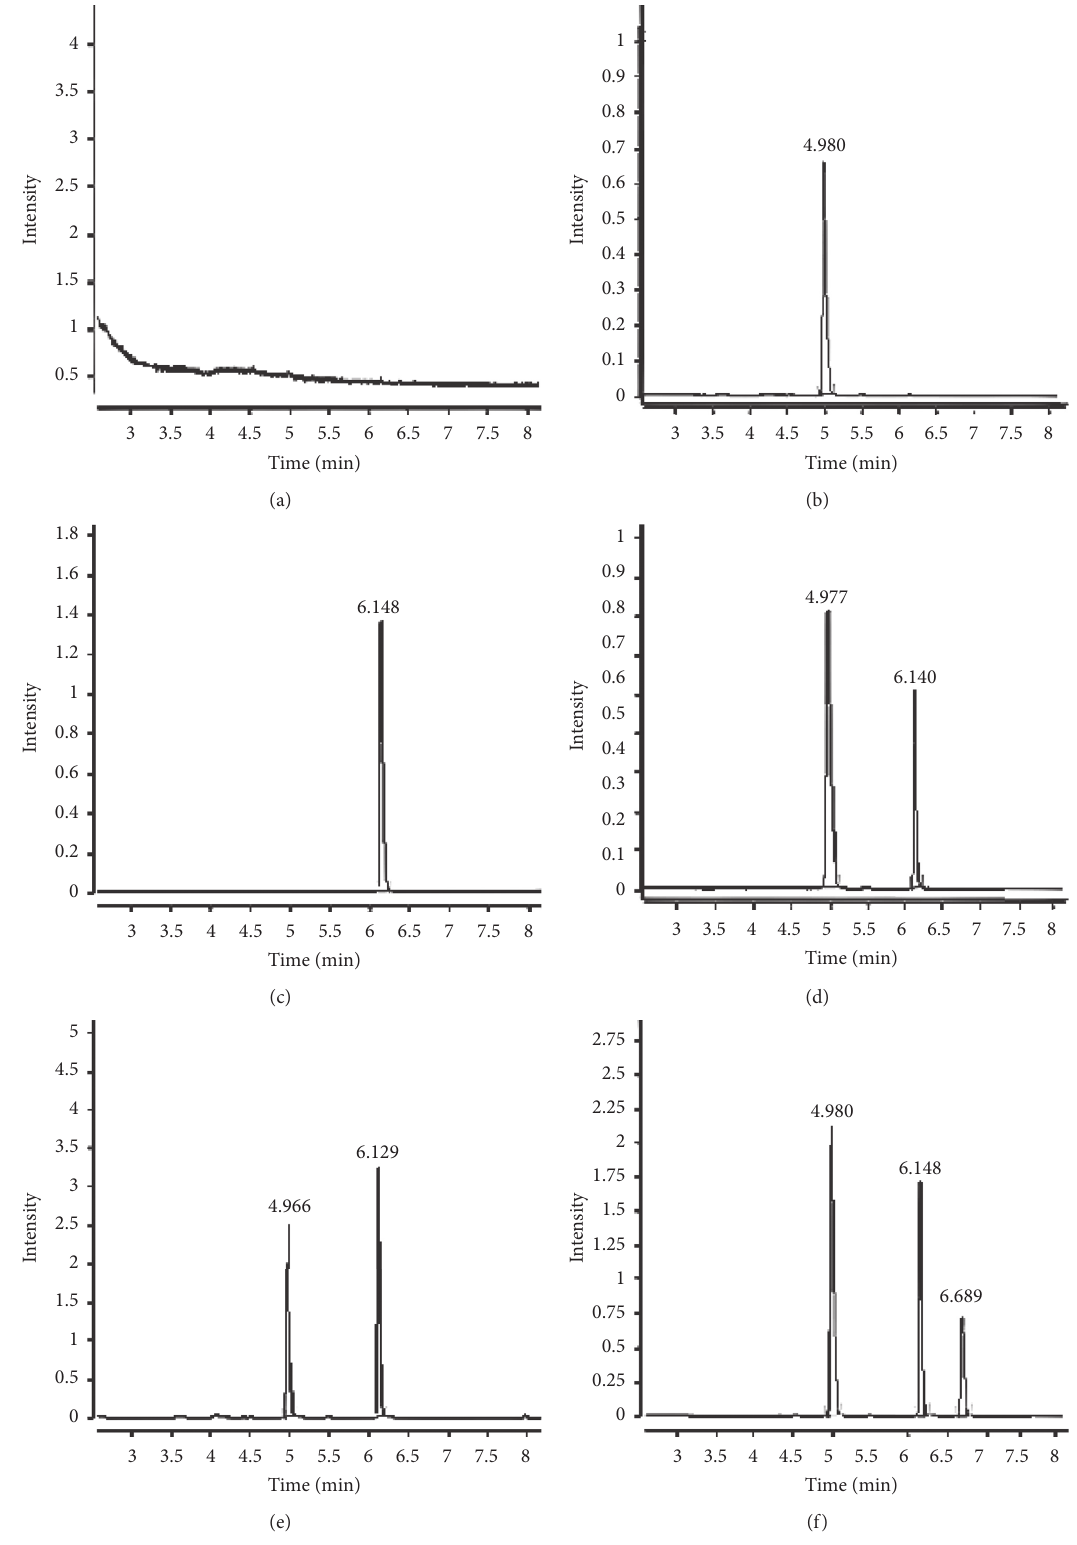
Figure 2: Chromatogram of blank reagent (a), methyl hexadecanoate solution (b), methyl stearate solution (c), mixed standard solution (d), sample solution 1 (e), sample solution 2